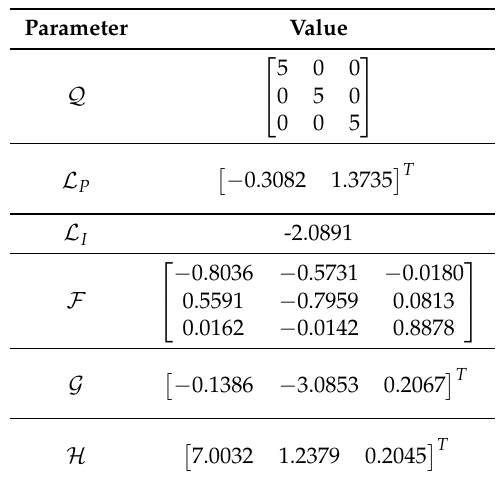
Table A2. Observer parameters.